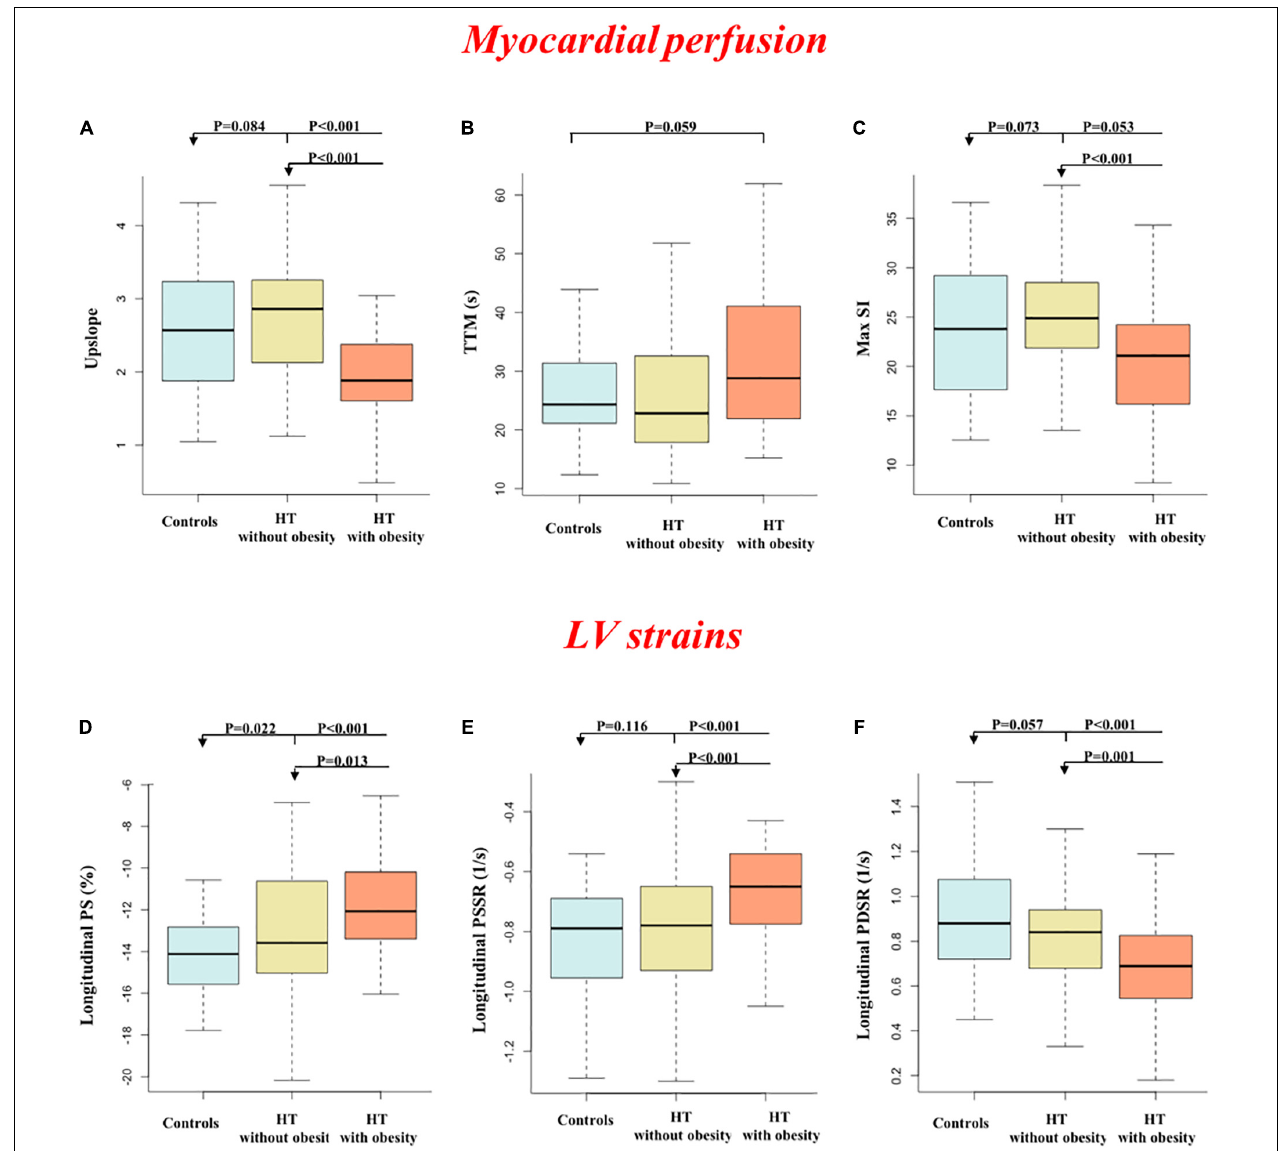
FIGURE 2 | Comparisons of first-pass perfusion (A–C) and left ventricular strains (D–F) between